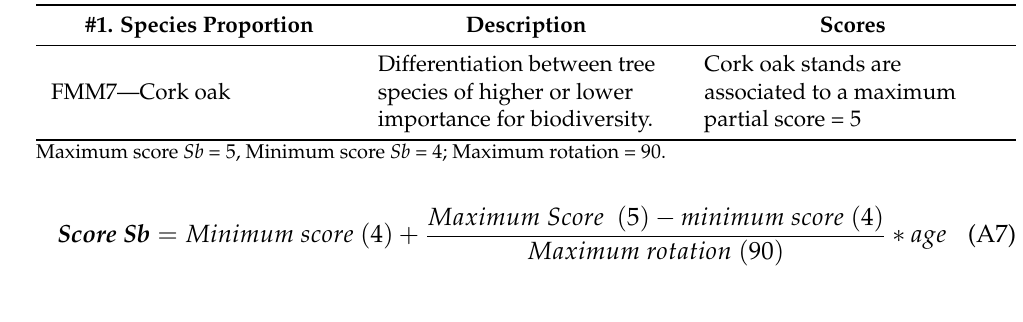
Table 7. Species proportion, description, minimum and maximum values used to define the FMM7 biodiversity